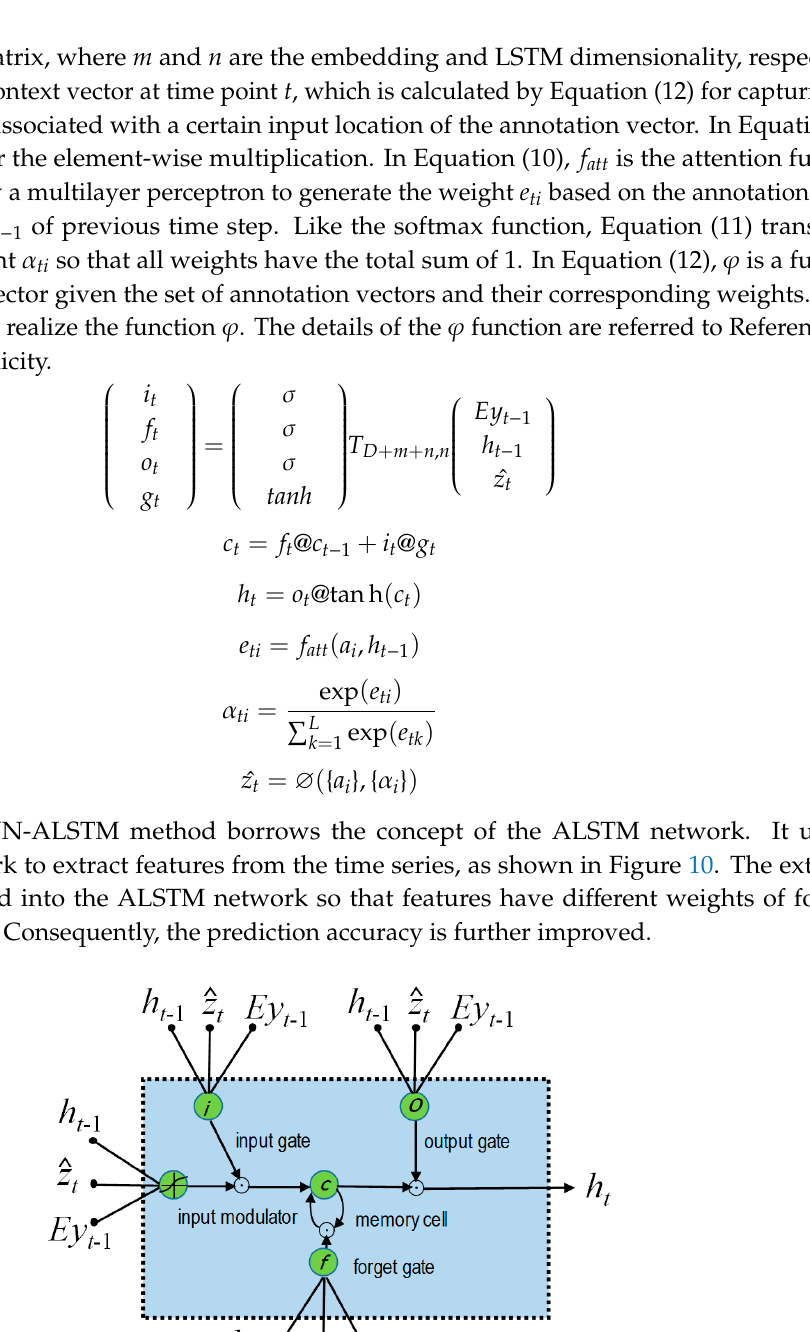
Figure 9. The structure of the ALSTM network.